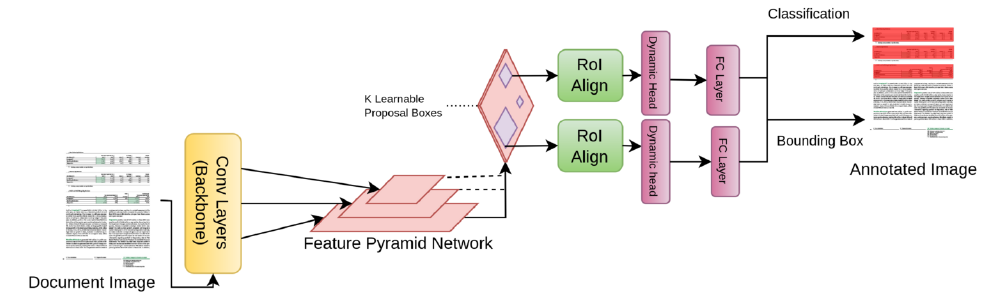
Figure 7. The detection pipeline for the Sparse R-CNN detection head. Sparse R-CNN proposes a paradigm shift by utilizing sparse and learnable proposal boxes and features instead of region proposal networks (RPNs).